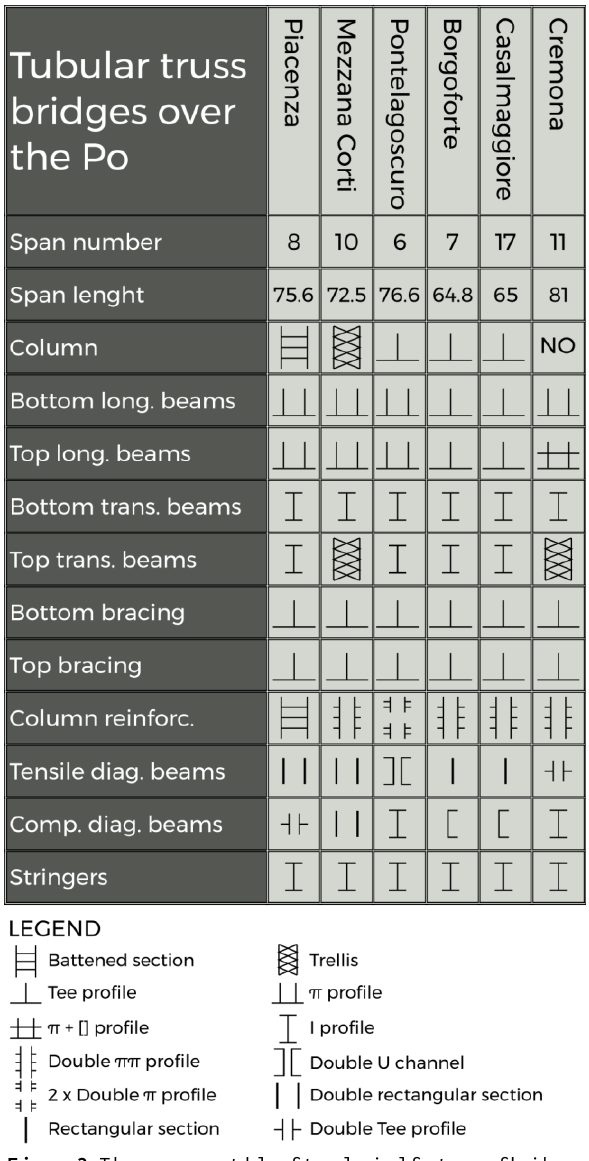
Figure 3 . The summary table of typological features of bridges.